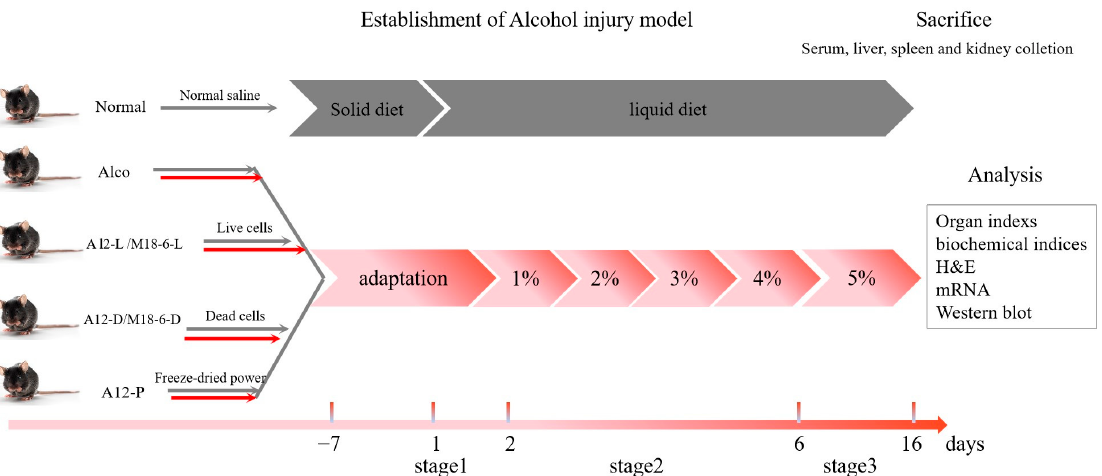
Figure 1. The Schedule of the experimental protocol and drug administration. (n = 12 per group).